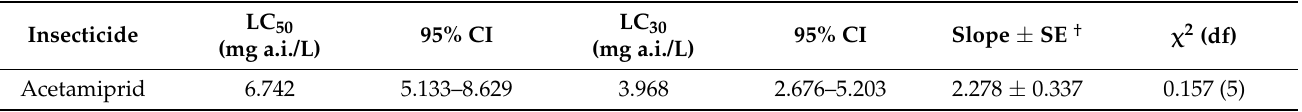
Table 1. Toxicity of acetamiprid on the first instar nymphs of Aphis glycines . LC 50 Insecticide (mg a.i./L) Acetamiprid